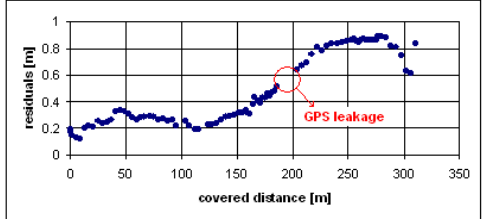
Figure 8. Differences between the photogrammetric and the GPS